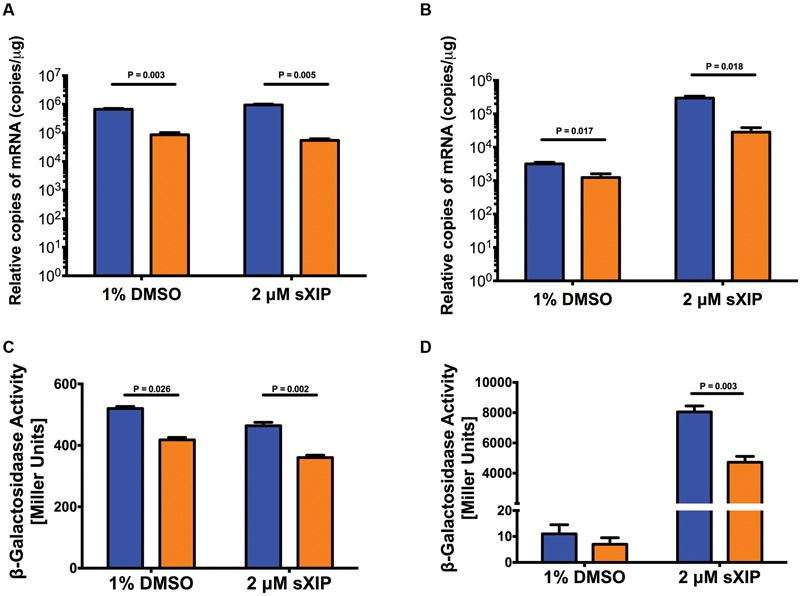
Impacts of loss of relA on com gene expression. Expression of comR
(A) and comX
(B) in S. mutans UA159 (blue bars) and its ΔrelA mutant derivative (orange bars) after addition of 2 μM sXIP. sXIP was added when OD600
nm reached 0.2. After 1 h of incubation, cells were harvested by centrifugation, RNA isolated, and qRT-PCR performed. Gene expression was normalized to 16S rRNA expression. Data represents three biological replicates measured in triplicate. Statistical analysis was performed by Student’s t-test. (C,D) Promoter activity from lacZ gene fusions to PcomR
(C) or PcomX
(D) in the wild-type (blue bars) and ΔrelA (orange bars) genetic backgrounds determined by β-galactosidase (LacZ) activity in cells grown in FMC and treated with either 1% DMSO or 2 μM sXIP. sXIP was added when OD600
nm reached 0.2. After an hour of incubation, cells were harvested by centrifugation and LacZ assays performed. Data represent three biological replicates assayed in triplicate. Statistical analysis was performed by Student’s t-test.